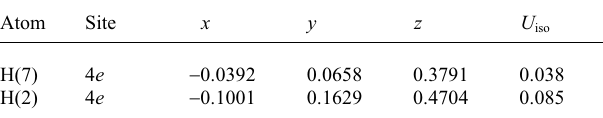
Table 2. Atomic coordinates and displacement parameters (in Å 2 )